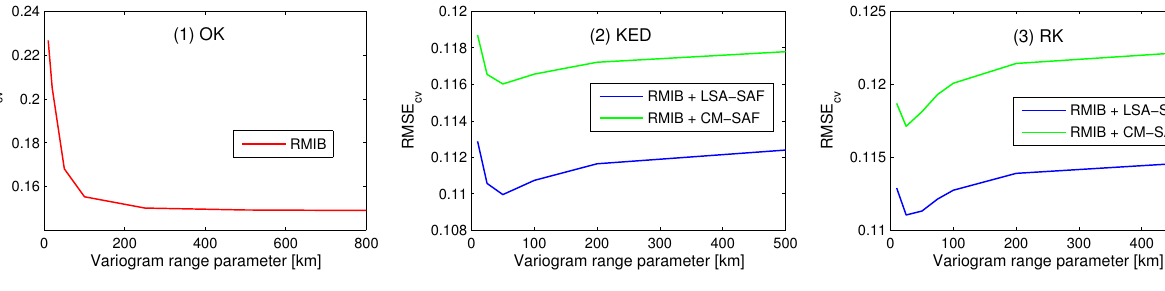
Figure 1. Distribution of the cross-validation root mean square error (RMSE cv ) as a function of the variogram range parameter ¯ d for the three kriging methods (left panel: OK; center panel: KED; right panel: RK). The SAFs’ products are used at the finest spatial resolution as auxiliary information for KED and RK (i.e., MSG pixel resolution for the LSA-SAF and 3 × 3km resolution for the CM-SAF).